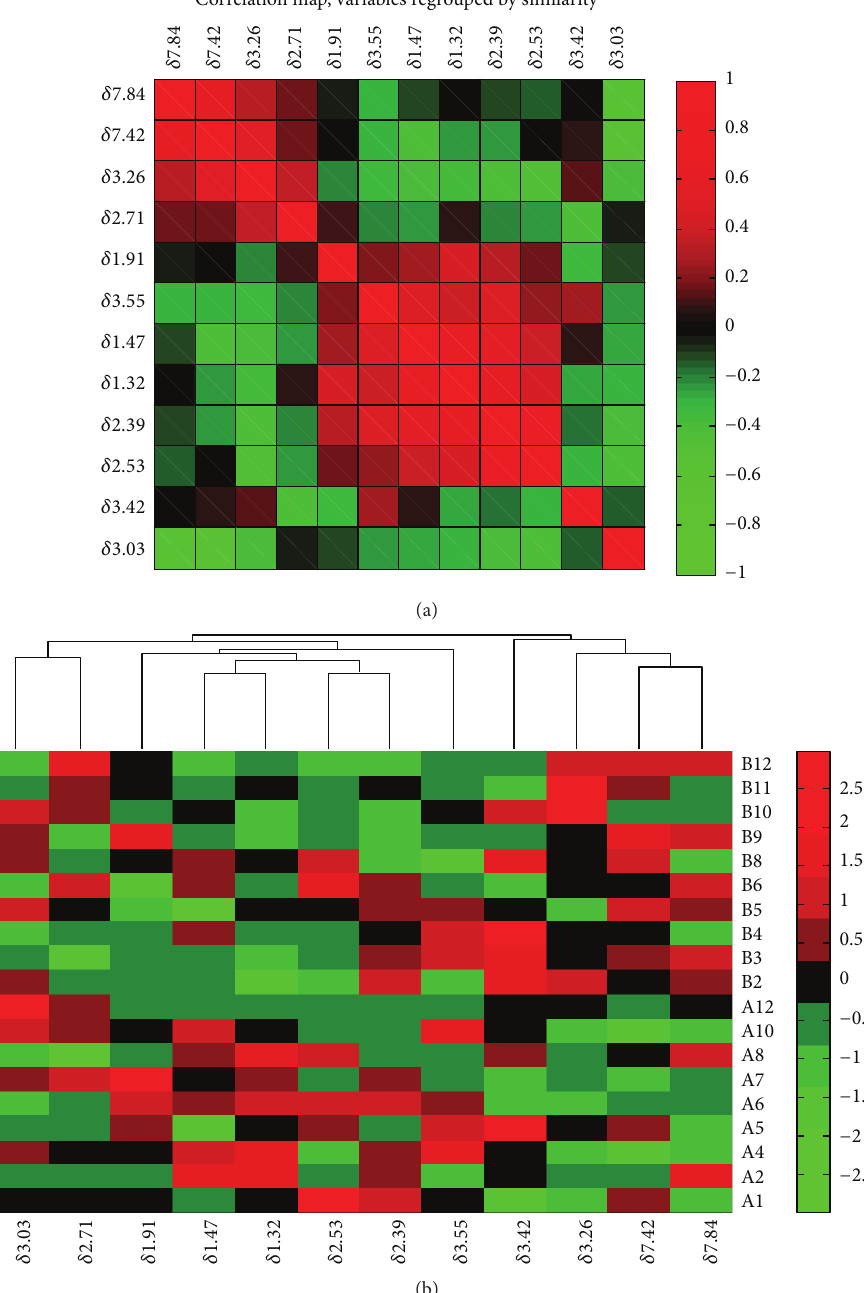
Figure 6: Correlation map (a) of the identified metabolites in stage I and stage II. Heat map (b) for identified metabolites in samples from first two stages (group A: first training stage; group B: second training stage). The upper dendrogram showed hierarchical clustering of variances corresponding to column data in the heat map. Rows: samples; columns: chemical shift of significant signal of metabolites.